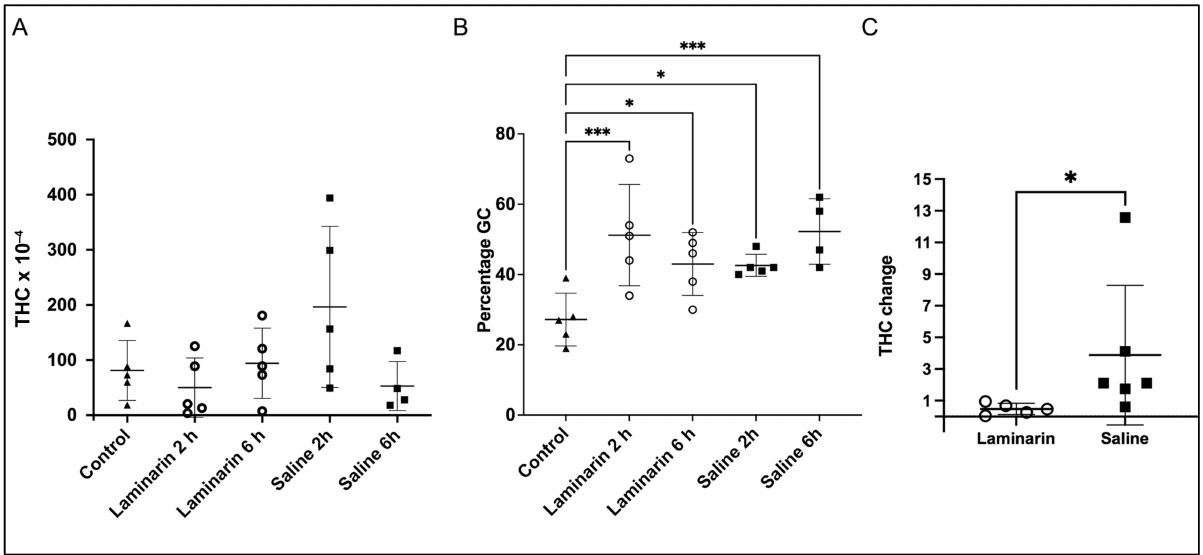
Figure 1. Total and differential hemocyte number in the circulation after saline or laminarin injection. ( A ) Total hemocyte count (THC) (cells per mL) in non-injected crayfish (control) and at two or six hours after injection of crayfish saline or laminarin (5 mg/mL) respectively. ( B ) Percentage of granular hemocytes in non-injected crayfish (control) and at two or six hours after injection of crayfish saline or laminarin (5 mg/mL), respectively. Line and error bars represent mean and standard deviations. Statistical analyses (were performed with one-way ANOVA (with Fisher LSD test) and asterisks * p -value < 0.05, *** p -value < 0.001 indicate significant differences compared to the control group. ( C ) Changes in total hemocyte number in the circulation after saline or laminarin injection. Each dot represents the relative hemocyte number in one individual crayfish six hours after injection compared to the number before injection in the same animal. The value one (1) in figure C means that no change occurred. Statistical analyses were performed with a Mann–Whitney test, and one asterisk (*) means p -value < 0.05, indicating significant differences between laminarin and saline